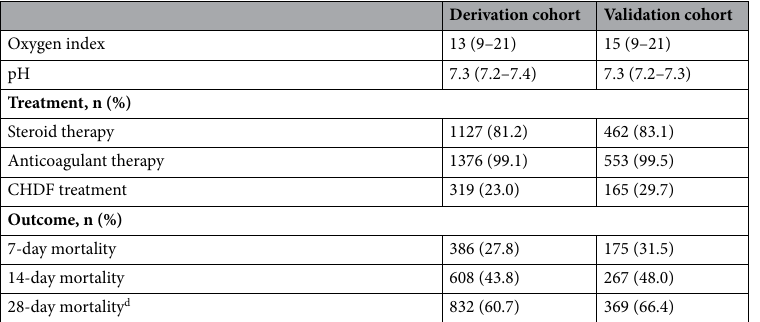
Table 1. Characteristics of adults with coronavirus disease 2019 presenting to 12 hospitals in the greater New York City area. IQR, interquartile range; BMI, body mass index; ER, emergency department; CKD, chronic kidney disease; ALP, alkaline phosphatase; Bil, bilirubin; BUN, blood urea nitrogen; CRP, C-reactive protein; NLR, neutrophil to lymphocyte ratio; Plat, platelet; RCDW, red blood cell distribution width; WBC, white blood cell; CHDF, continuous hemodiafiltration. a Missing data is summarized in eTable 1 in the Supplement. b Race was collected by self-report in prespecified fixed categories. c Other insurance includes military, union, and workers’ compensation. d We performed analysis by using data from 1389 patients in the derivation cohort and 556 patients in the validation cohort.